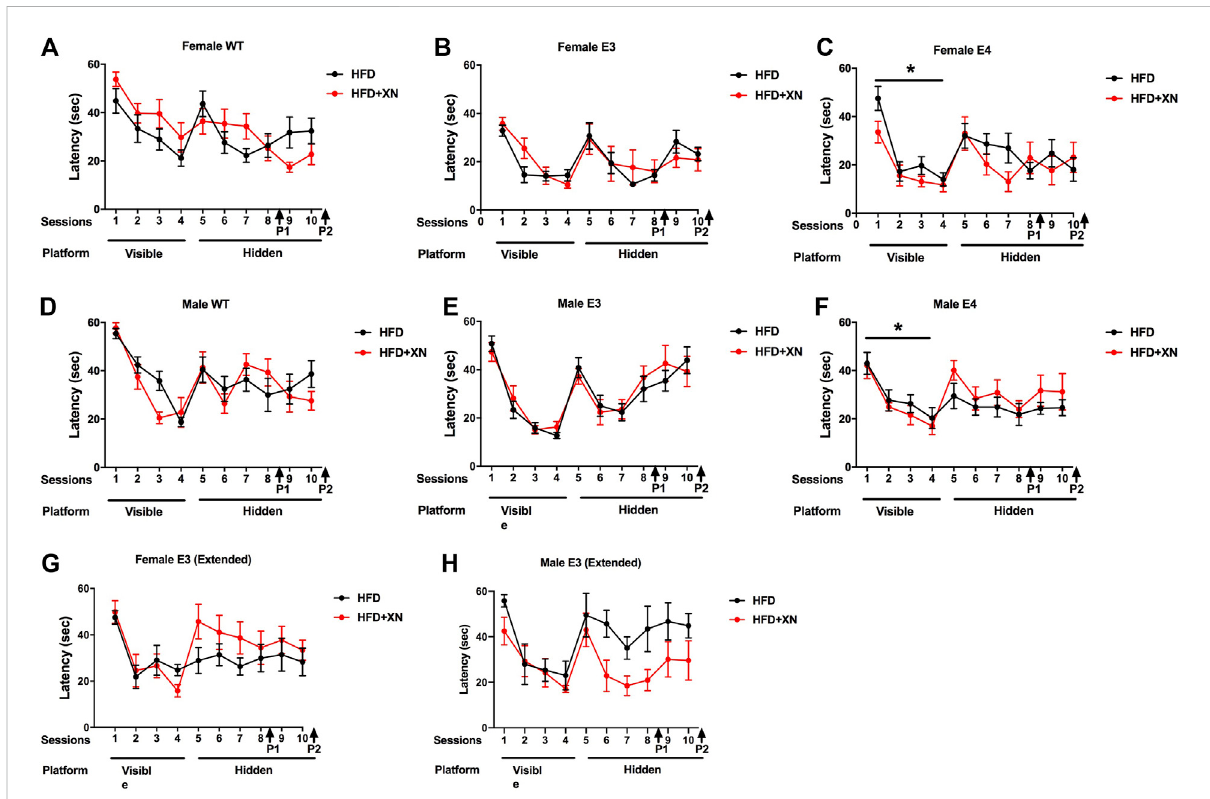
FIGURE 3 Spatial learning and memory of female WT (A) , E3 (B) , E4 (C) and male WT (D) , E3 (E) , and E4 (F) in the water maze in the standard exposure experiment. The latency to locate the platform is shown. Mice were fi rst trained in 4 sessions in which the platform location was visible, and subsequently they were trained to locate a hidden platform using extra-maze cues. In E4 mice, XN treatment improved performance during the visible platform training. * p < 0.05. ( G,H) Spatial learning and memory of female (G) and male (H) E3 mice during the extended exposure experiment. There was a treatment by sex interaction during hidden platform training. XN improved performance of E3 males only (H) . * p = 0.029. There was no signi fi cant effect of treatment on performance of females during the hidden platform training (G) .